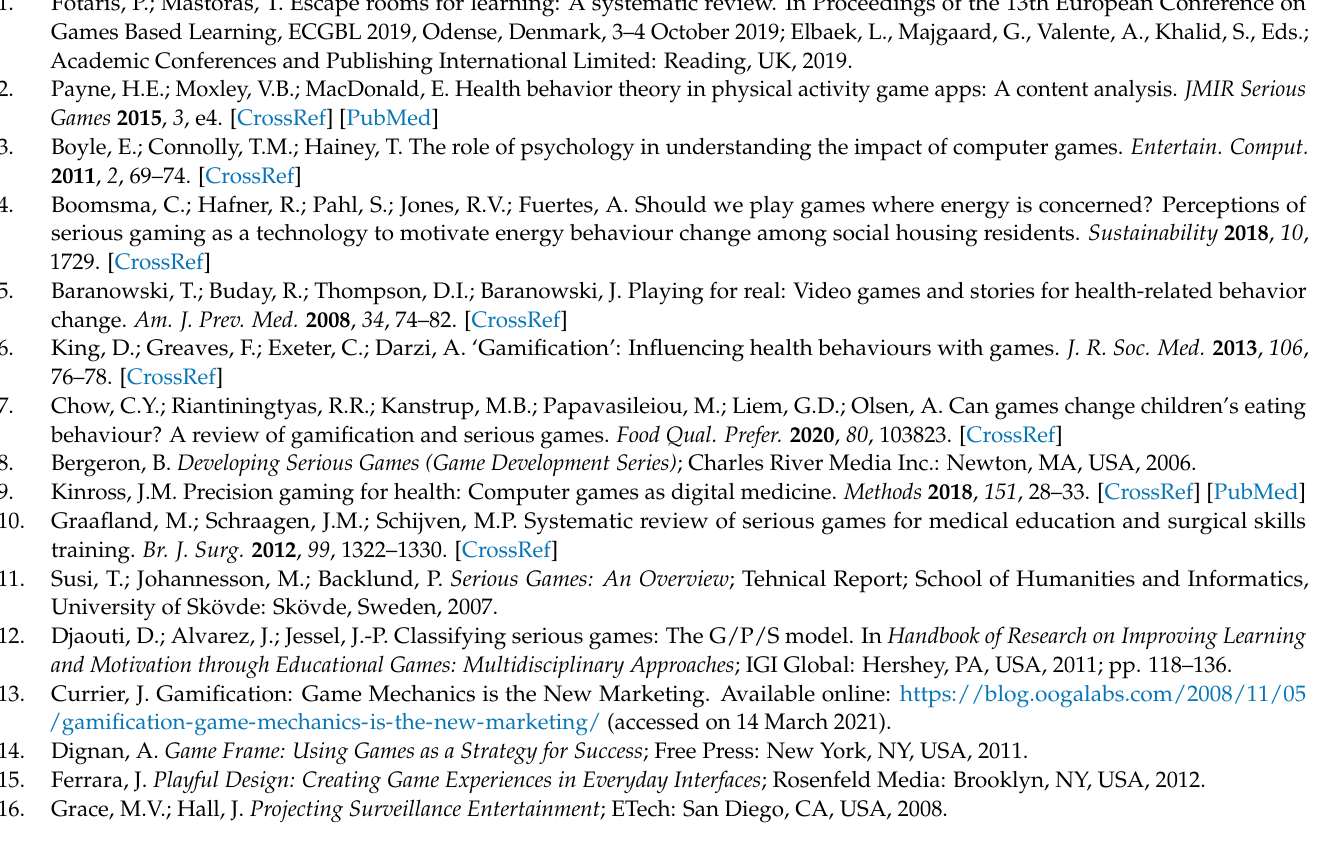
Table S2: Full Classification of Behaviour Change